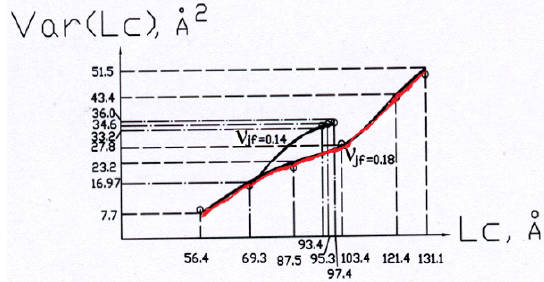
Figure 2. Thermomechanical variance of the molecular length with solid lines corresponding to our theory for cases with ν data denoted by circles.